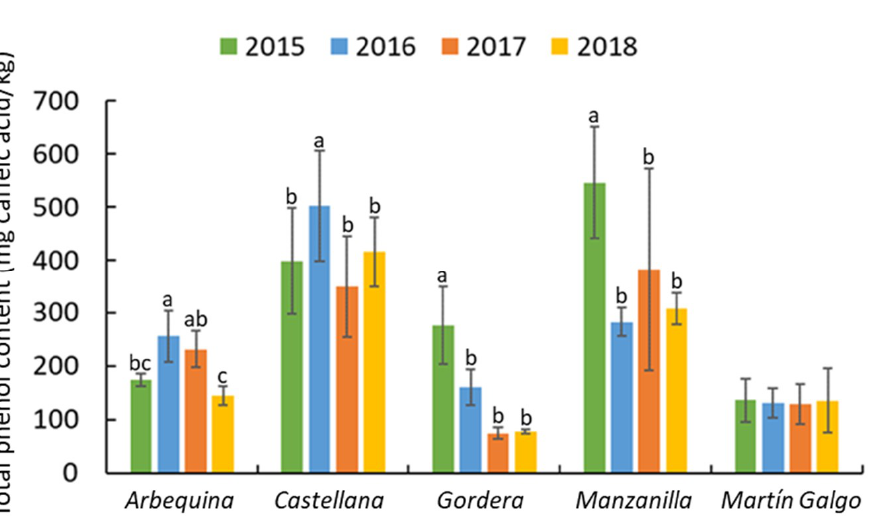
Figure 6. Total phenol content of the monovarietal oils produced with the varieties of olives grown in the Aceite de la Alcarria PDO during the four consecutive olive crop seasons under study. Mean values of the samples elaborated in each season. Different letters within each variety indicate significant differences among seasons (Duncan test, p < 0.05).